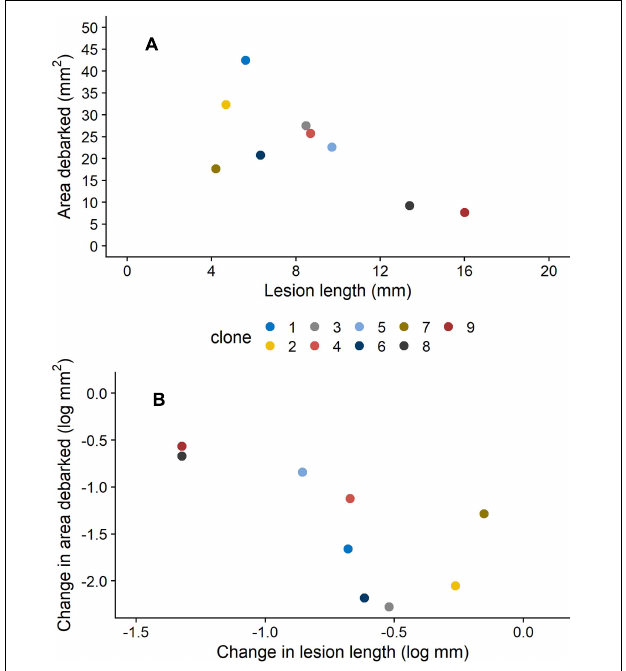
FIGURE 2 | Relationship between (A) estimated means (from models presented in Table 1 ) for area debarked (mm 2 ) by pine weevils ( H. abietis ) and lesion lengths (mm) inflicted by the blue-stain fungus ( E. polonica ) on Norway spruce ( P. abies ) clones (1–9) treated with 0 mM methyl jasmonate (MeJA), and (B) the change in area debarked (log mm 2 ) and lesion length (log mm; i.e., slope coefficients of reaction norms) that occurred for each clone between the 0 and 50 mM MeJA treatments. Clones in the 0 mM MeJA that received little pine weevil damage experienced longer fungal lesion lengths, and vice versa [panel (A) ]. Clones that exhibited a minor difference (i.e., decrease) in area debarked between the 0 and 50 mM MeJA treatment, experienced a greater change (i.e., decrease) in fungal lesion lengths between these two treatments [panel (B) ]. For clone 1, plants in the 50 mM were not included the experiment (see section “Materials and Methods”), so results for the 25 mM MeJA treatment are presented instead. Estimates ± standard error for area debarked and lesion length, per clone and treatment combination, can be found in Supplementary Table 3